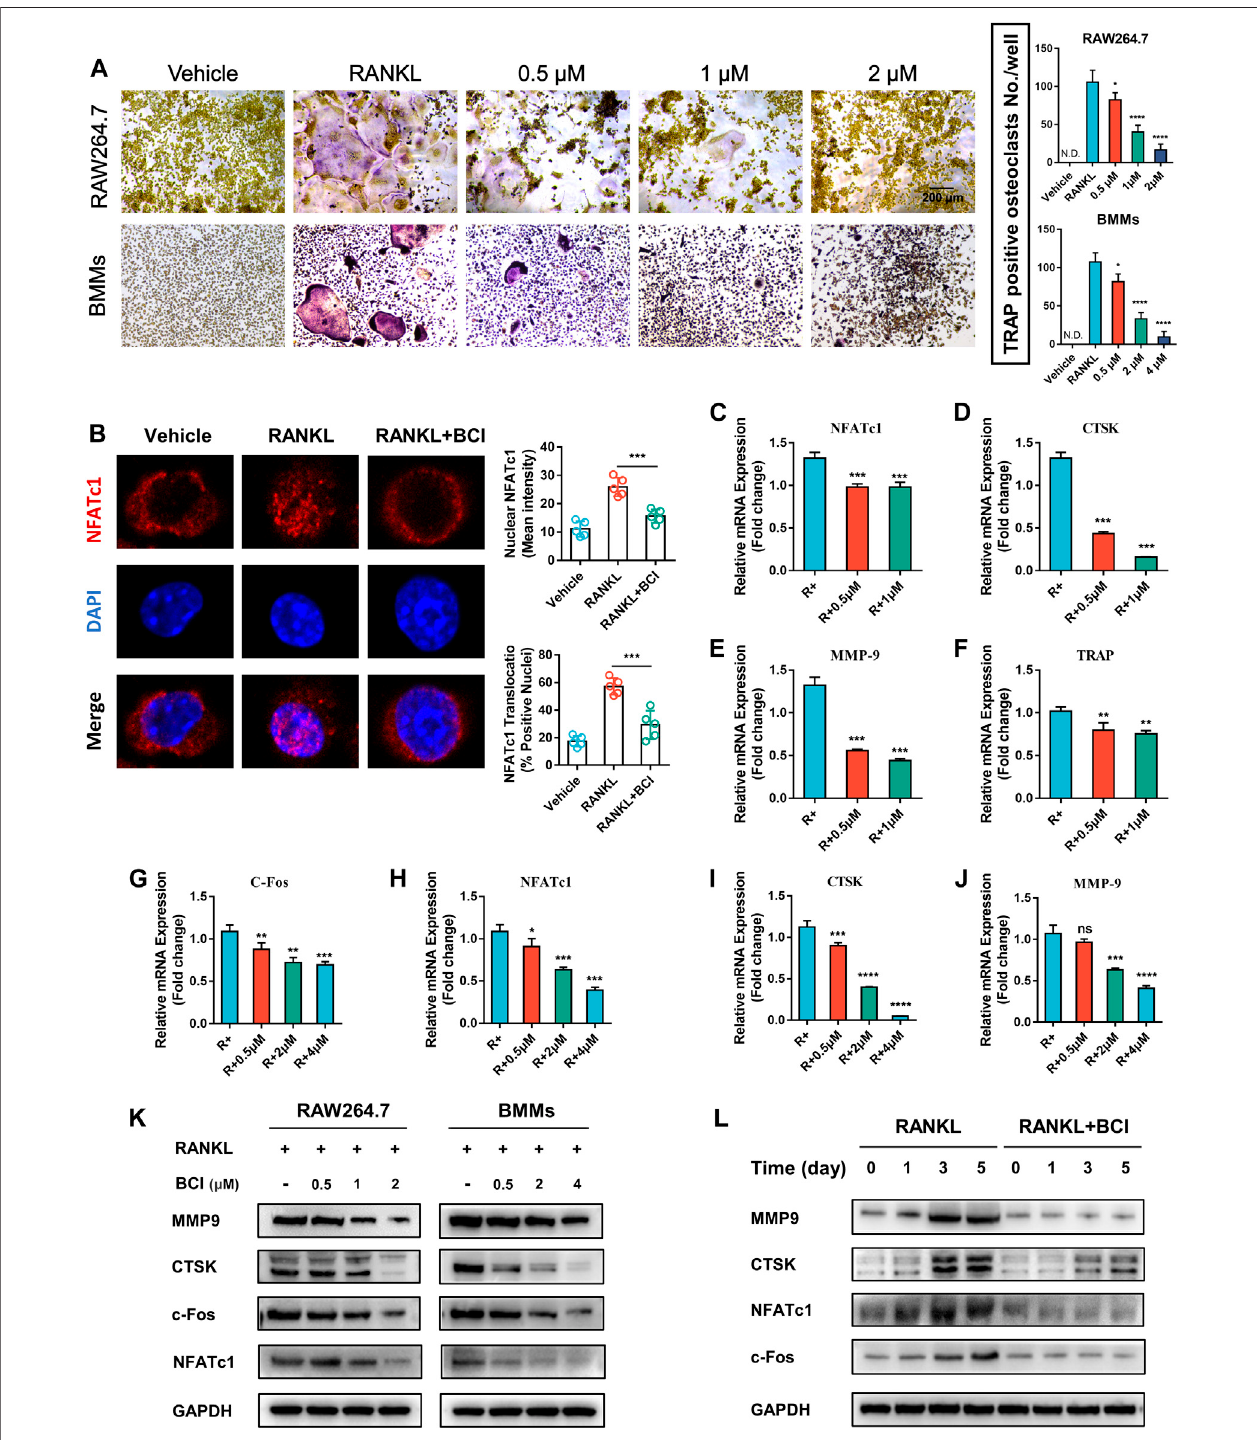
FIGURE 2 | BCI suppresses RANKL-induced osteoclast differentiation. (A) TRAP staining results showing the effects of different doses of BCI on osteoclast differentiation. (B) Immuno fl uorescencestainingofNFATc1nucleartranslocationaccordingtoBCItreatment.qRT-PCRanalysisoftheexpressionofosteoclast-speci fi c genes (CTSK, MMP9, NFATc1, and c-Fos) during osteoclastogenesis in BCI-treated (C – F) RAW264.7 cells and (G – J) BMMs. (K) Western blot analysis of osteoclast marker levels during RANKL-induced osteoclastogenesis and at different BCI dosages. (L) Western blot analysis of osteoclast marker levels during RANKL- induced osteoclastogenesis following BCI treatment for the indicated times. * p < 0.05, ** p < 0.01, *** p < 0.001.